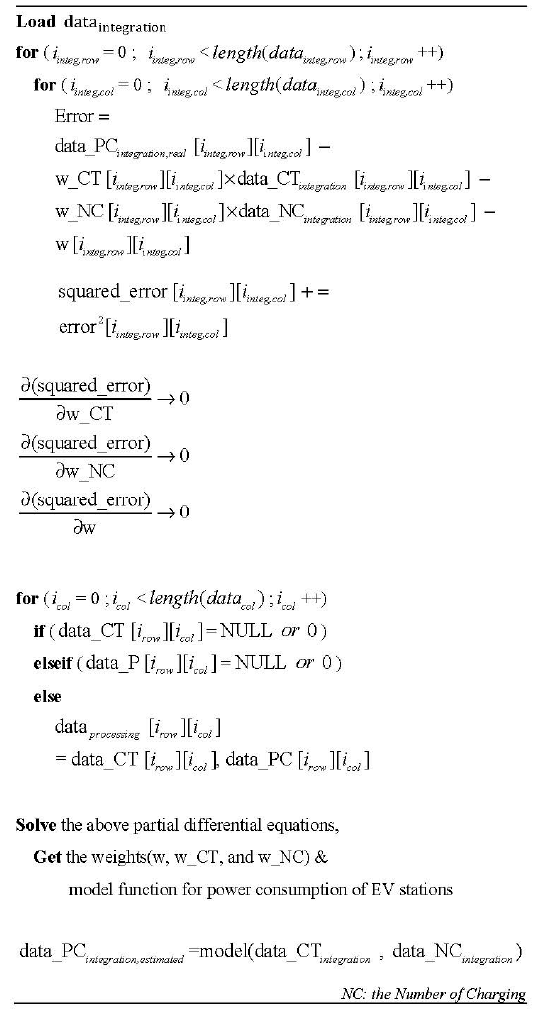
Figure 9. Pseudo code of data